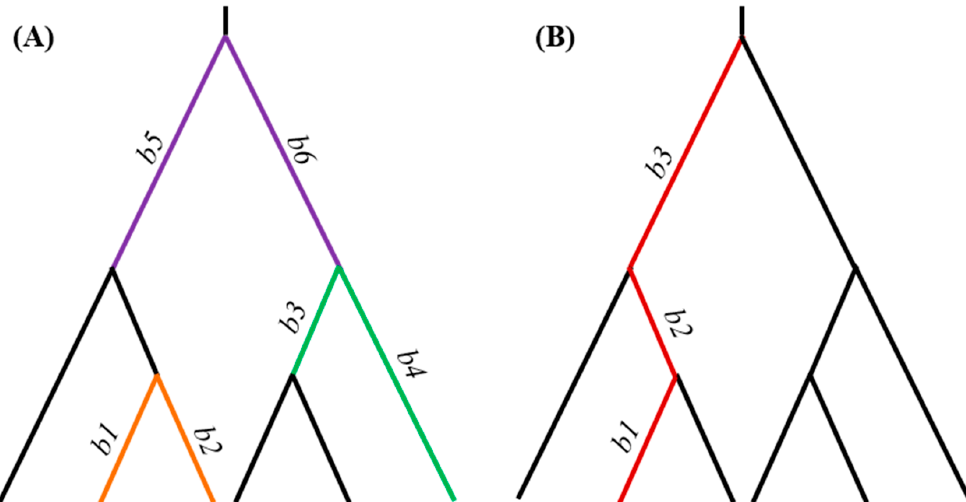
Figure 2. Types of branch pairs that are excluded from comparisons. ( A ) Neighboring branch pairs (e.g., b1-b2, b3-b4, and b5-b6) are excluded from the analysis because it is not possible to infer parallel and convergent substitutions in these pairs. Other such branch pairs exist. ( B ) An example of three branches sharing the same evolutionary path is shown. Branch pairs b1-b2, b1-b3, and b2-b3 are excluded from the analysis because they violate the independent-evolution requirement. Other such branch pairs exist.